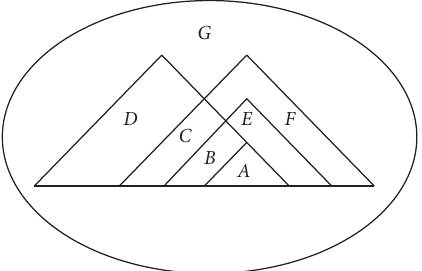
Figure 2: The relationships among AG- (r,l) -Loop and AG -(l,r )- Loop.